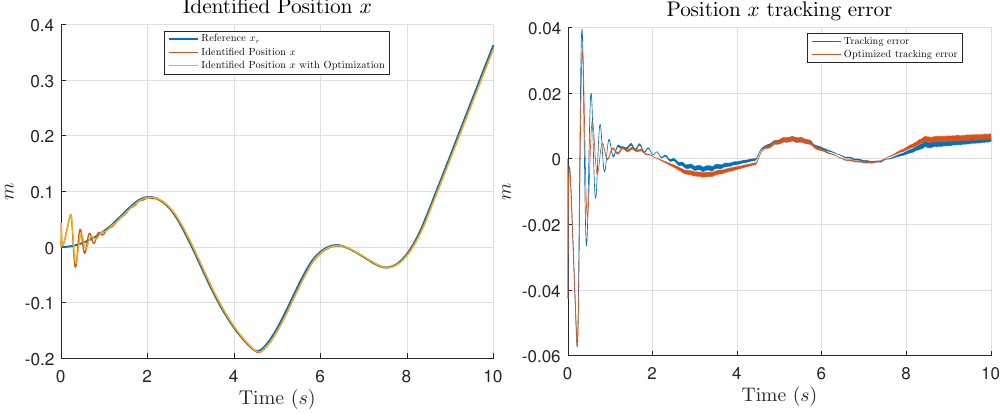
Figure 6. Tracking of x position ( left ) and error comparison ( righ t) for the simulation test.